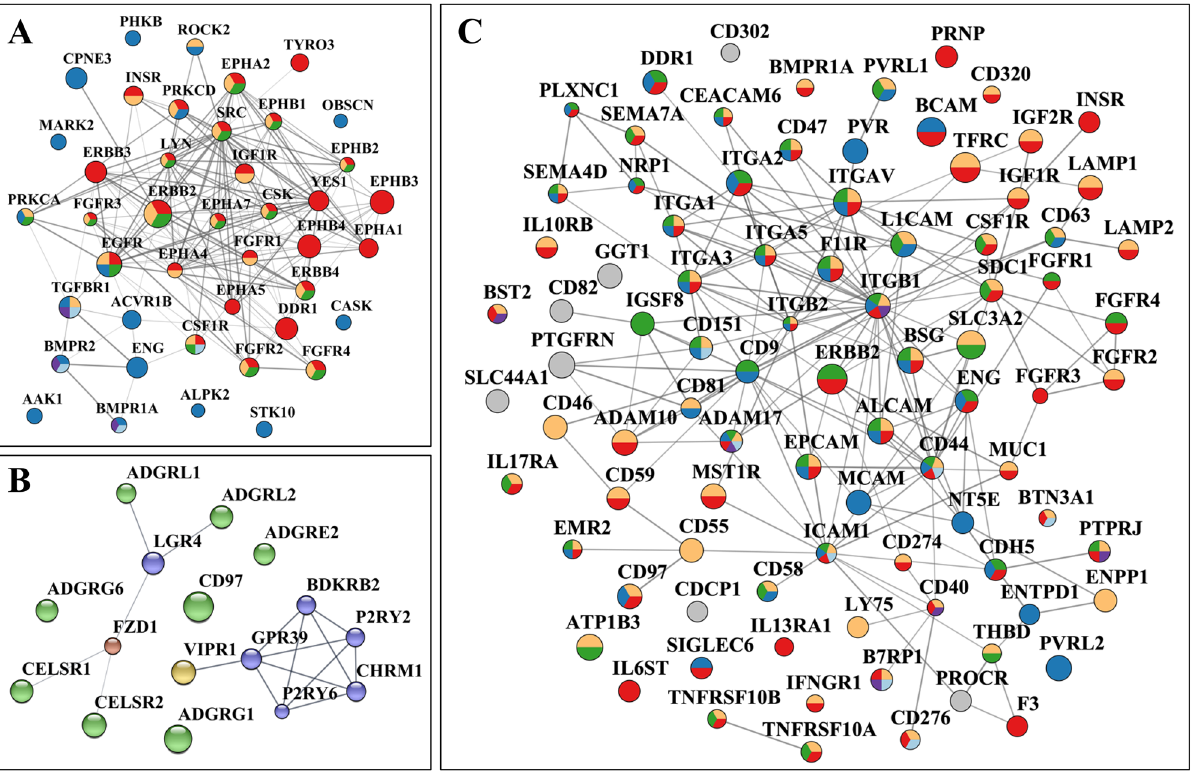
Figure 7. Protein–protein interaction networks of selected cell-membrane protein categories. ( A ) Receptor kinases: Red-Tyr kinase receptors (EGFRS, FGFRs, ephrins, DDR1), Blue-Ser/Thr kinase receptors (TGFBR1, BMPRs), Yellow-MAPK regulation, Green-ERK1/ERK2 regulation, Light blue-Cytokine-cytokine receptor signaling, Magenta-TGFB signaling. ( B ) G-protein coupled receptors: Blue-Class A Rhodopsin (P2RY2, P2RY6, CHRM1, BDKRB2, GPR39), Yellow-Class B1 Secretin (V1PR1), Green-Class B2 Adhesion (ADGRL1/2, ADGRG1/6, ADGRE2, CELSR1/2, CD97), Red-Class F Frizzled (FZD1). ( C ) CD antigens: Classical receptors (ERBB2, FGFRs, IGFRs, TNFRs, TFRC, ILs, IFNs), integrins and integrin binding proteins (ITGAV, ITGAs, ITGBs, semaphorins), CAMs (EPCAM, BCAM, ICAM1, L1CAM, MCAM, CDH5/CD144, mucins, nectins), and Disintegrin metalloproteinase domain-containing proteins (ADAM10/17); Yellow-Immune system process, Blue-Biological adhesion, Red-Cell communication, Green-Locomotion, Magenta-B cell activation, Light